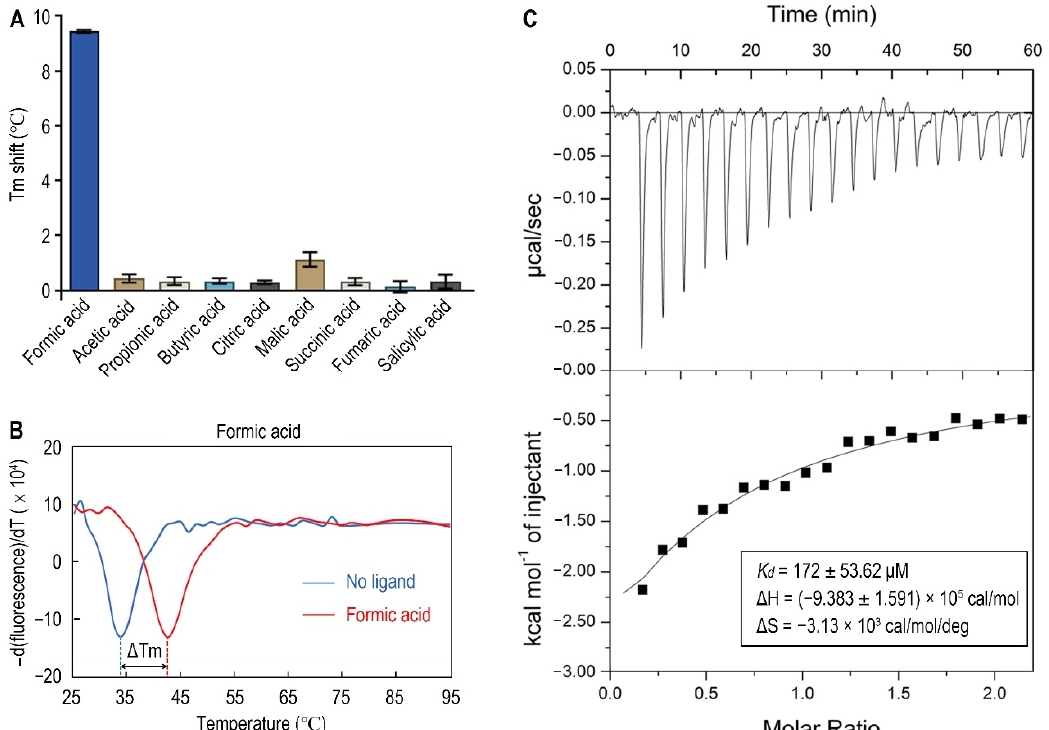
Figure 3. The binding of formic acid to Atu0526 LBD . ( A ) Thermo shift assay of different organic acids. The column values represent the T m of Atu0526 LBD with the corresponding ligands minus the T m without ligand. Column values are the means of three biological replicates with the SD. ( B ) The binding analysis of formic acid to Atu0526 LBD using a thermo shift assay. The data are presented in the form of changes in the derivative of fluorescence intensity with temperature. The temperature corresponding to the red and blue dashed lines are the Tm values of Atu0526 with and without formic acid, respectively. ( C ) Isothermal titration calorimetry of Atu0526 LBD with formic acid. The upper panel depicts the raw titration data. The lower panel is the isotherm derived by integrating peaks from the raw data and the calculated values of K d , ∆ H and ∆ S. Data points were fitted with the “one binding site model” of ORIGIN.